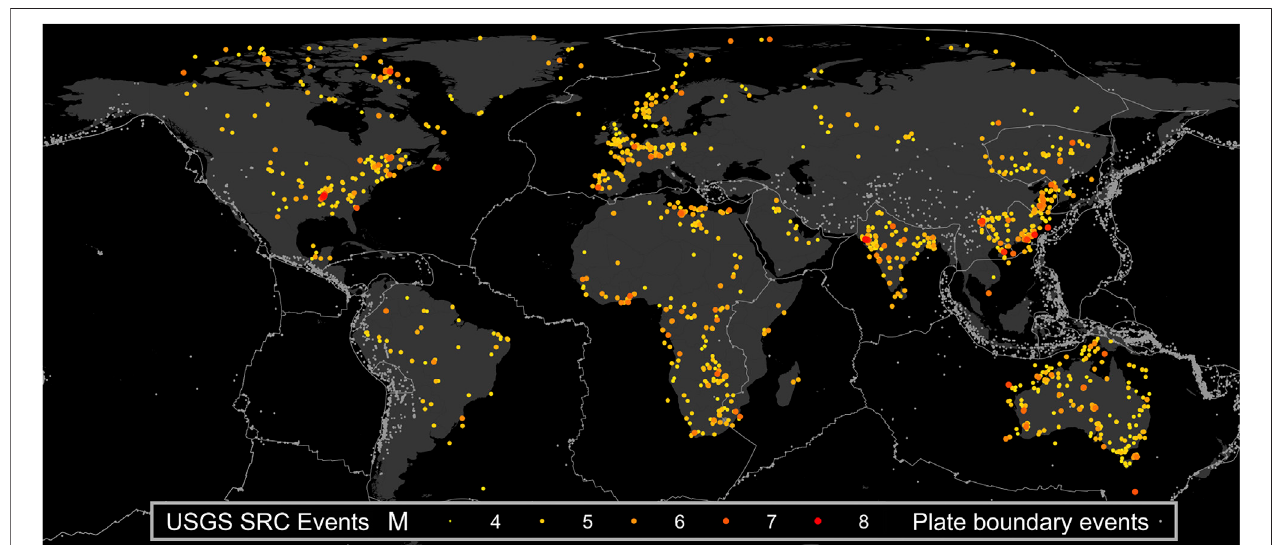
FIGURE4| IntraplateeventsfromtheStableContinentalRegionsdatabasefromtheUSGS(495 – 2002)(USGS,2004).PlateboundariesfromBird(2003),withM6 + plate boundary earthquake events from the USGS Earthquake Catalog from 1950 to 2019 in gray to show range of continental plate boundary widths (USGS,